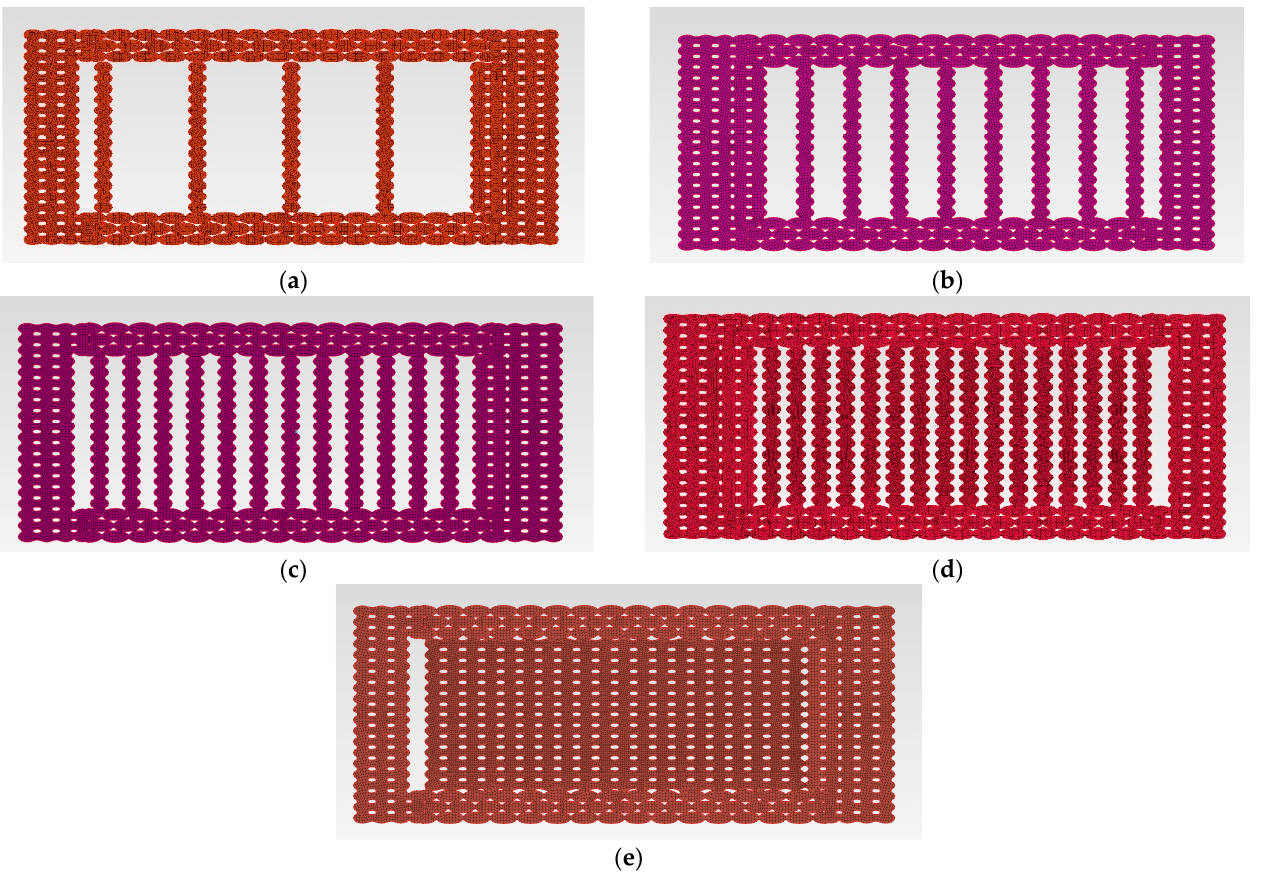
Figure 13. Cross-sections patterns according to infill rate: ( a ) 20%; ( b ) 40%; ( c ) 60%; ( d ) 80%; ( e ) 100%. Table 2. Estimated cross-sectional areas according to infill rate and mesh size. Infill Rate